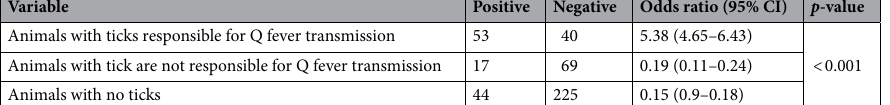
Table 7. Association of tick species with seroprevalence of Q fever with χ 2 test.